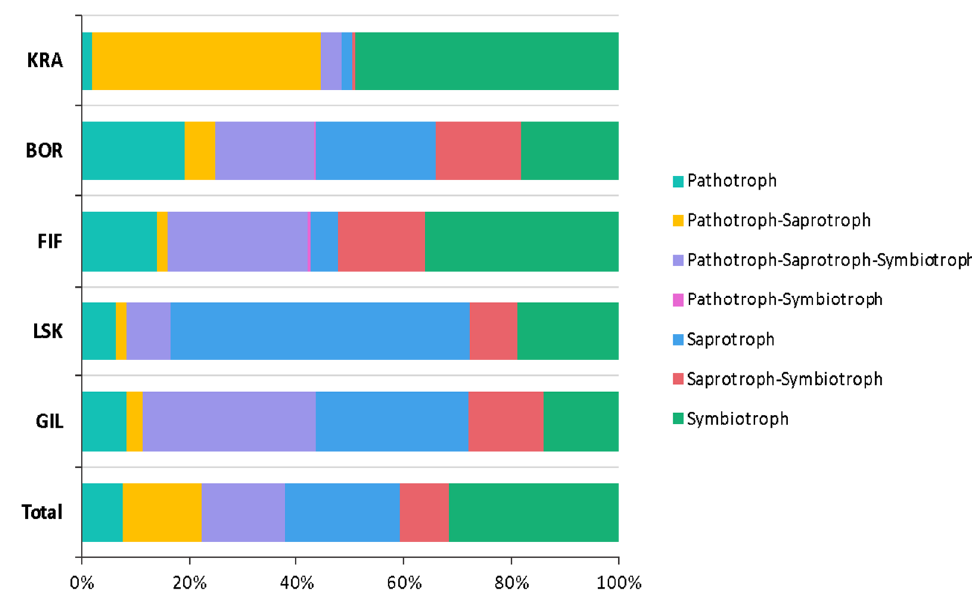
Figure 2. Proportion of different functional groups of biocrust fungi identified by the FUNGuild database.